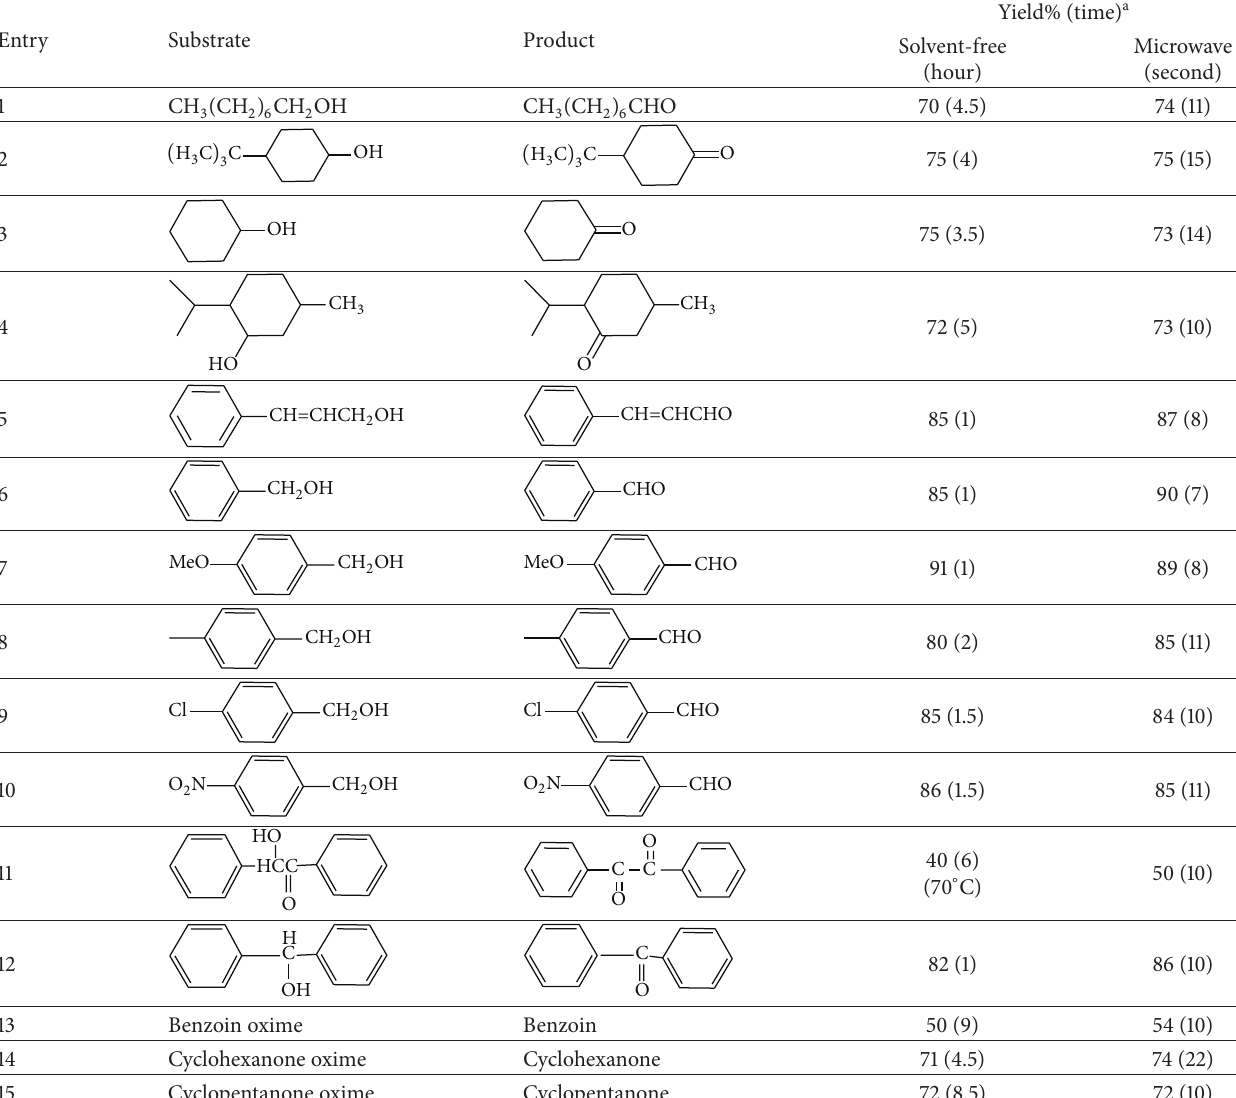
Table 4: The oxidation of alcohols and oximes with TMGCC under solvent-free conditions at room temperature and under microwave irradiation.